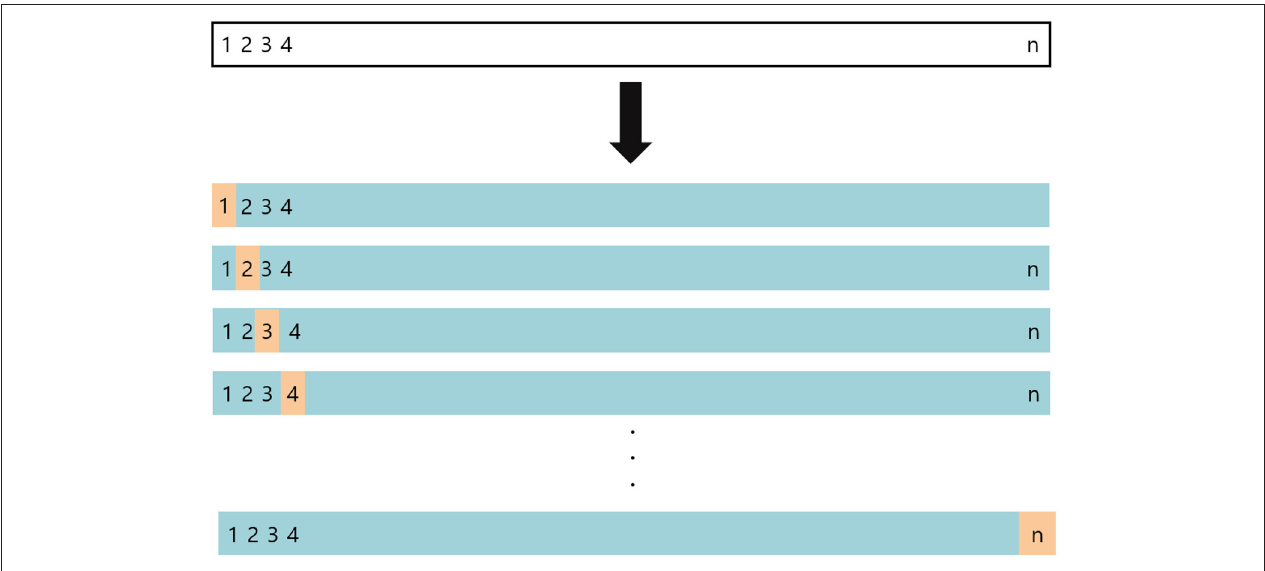
FIGURE 3 | The concept of the LOOCV method.